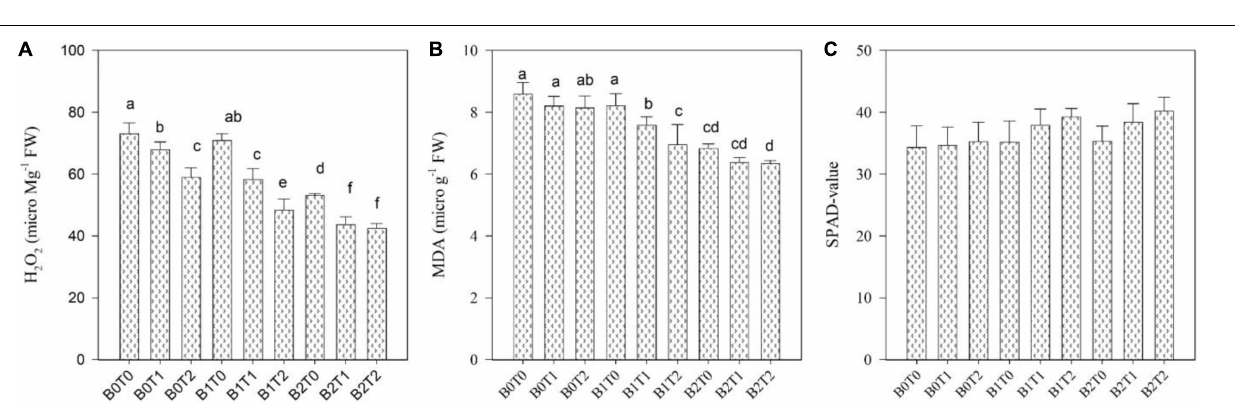
Figure 4 | Effect of combined application of TU and BC on (A) hydrogen peroxide (H 2 O 2 ), (B) malondialdehyde (MDA), and (C) SPAD value grown under Cd contamination. Values are averages ± SD ( n = 3). Different statistical letters represent significant differences in values between treatments ( p < 0.05). TU, thiourea;